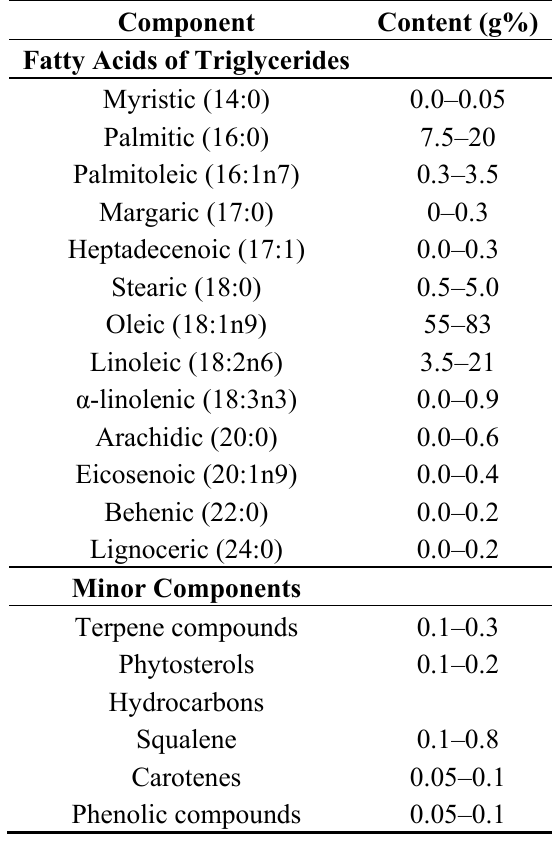
Table 1. Composition of virgin olive